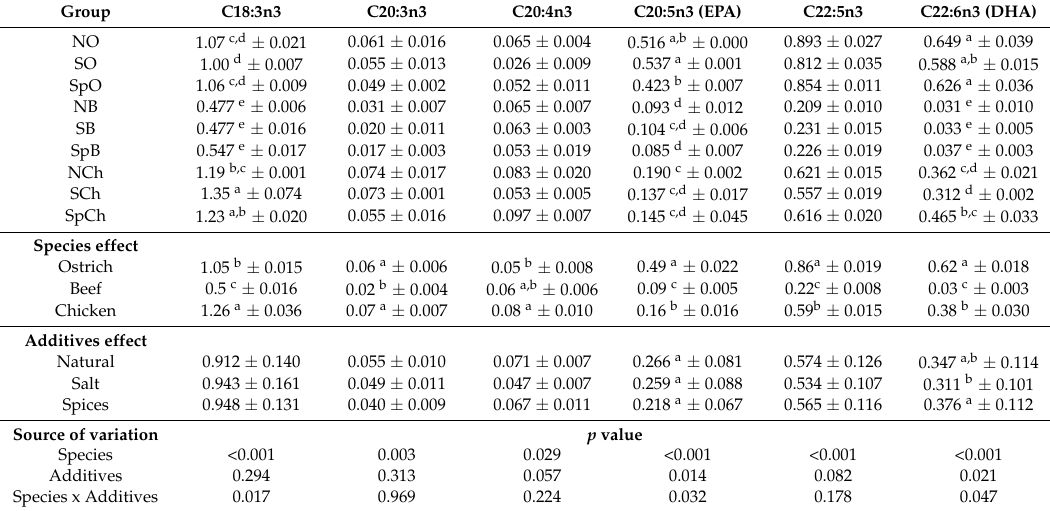
Table 4. Polyunsaturated fatty acid n -3 group composition in dried meat (%) (mean ±